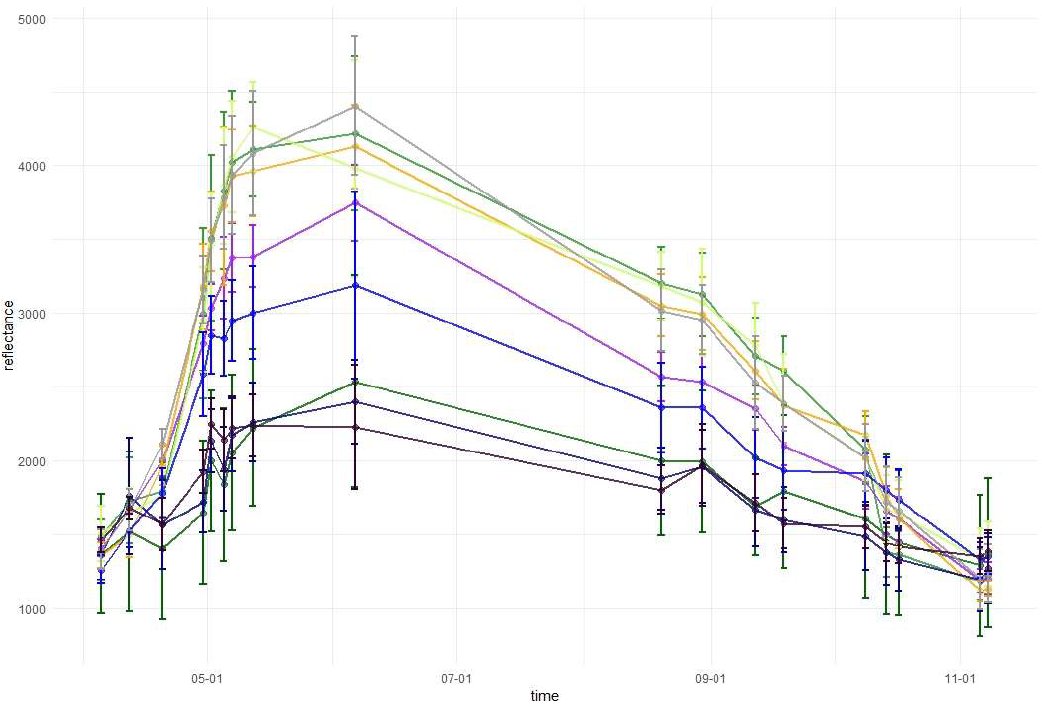
Figure A6. Mean and standard deviation values of reflectance in the red-edge 3 band. Figure A6 . Mean and standard deviation values of reflectance in the red-edge 3 band.